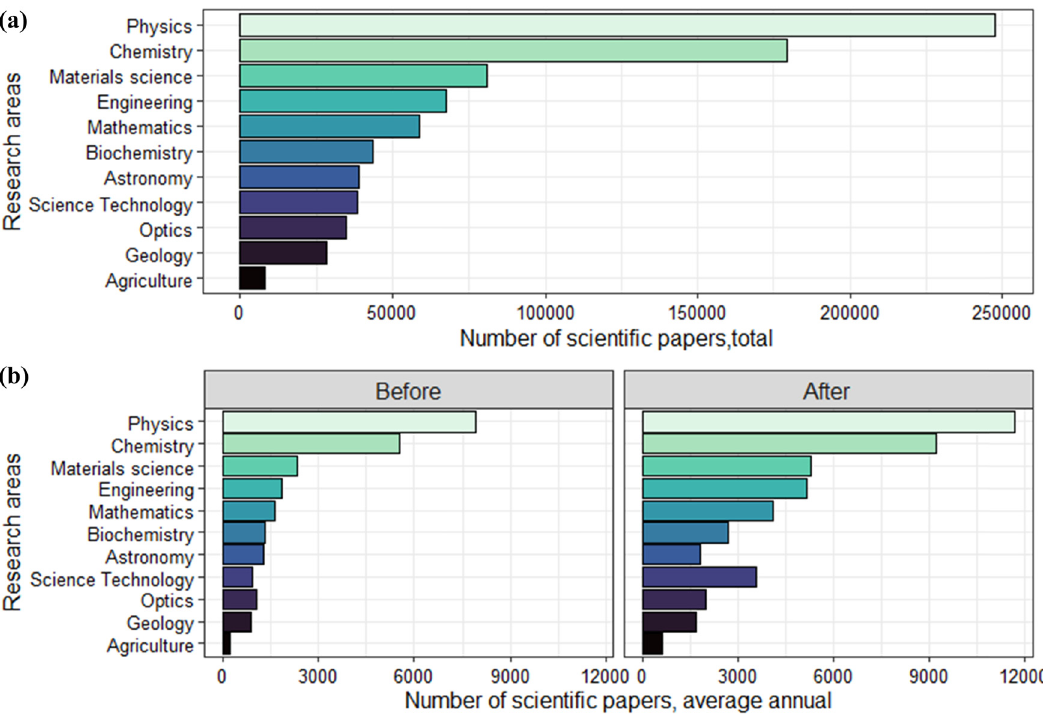
Figure 2: The number of scienti fi c papers by research areas with Russian and foreign co - authorships from 1992 to 2020. ( a ) Total number of published scienti fi c papers for the period. ( b ) Average annual publications separated before and after the project “ Science. ” Source: Own calculation using R software 4.0.2 ( 2021 ) based on the data aggregated by the Clarivate Analytics, WoS Core Collection ( 2021 ) .